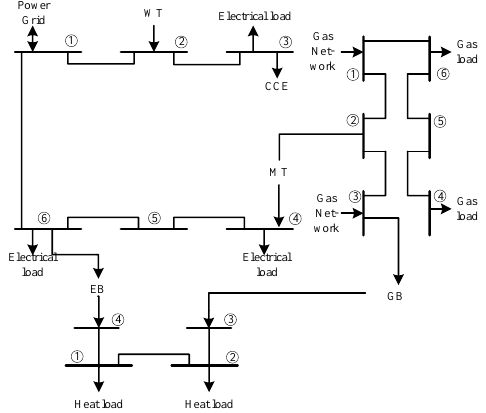
Figure 3. The PIES test system. PIES’s equipment operating parameters are shown in Table